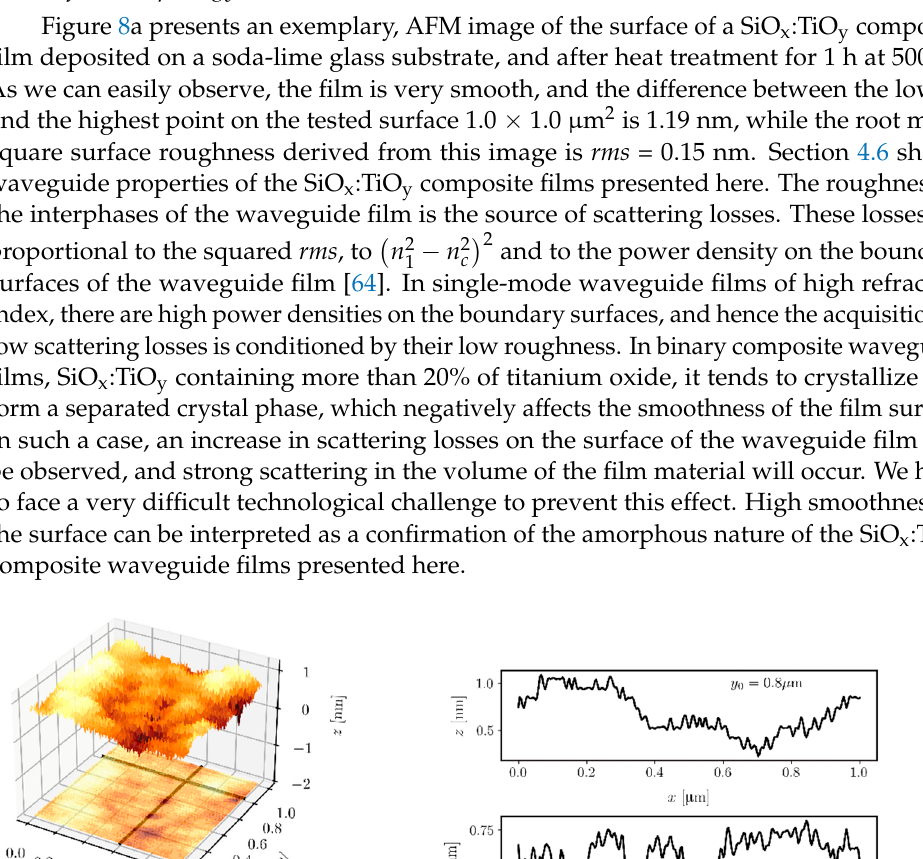
Figure 9. SEM images of top ( a ) and cross section ( b ) of the slab waveguide structure.